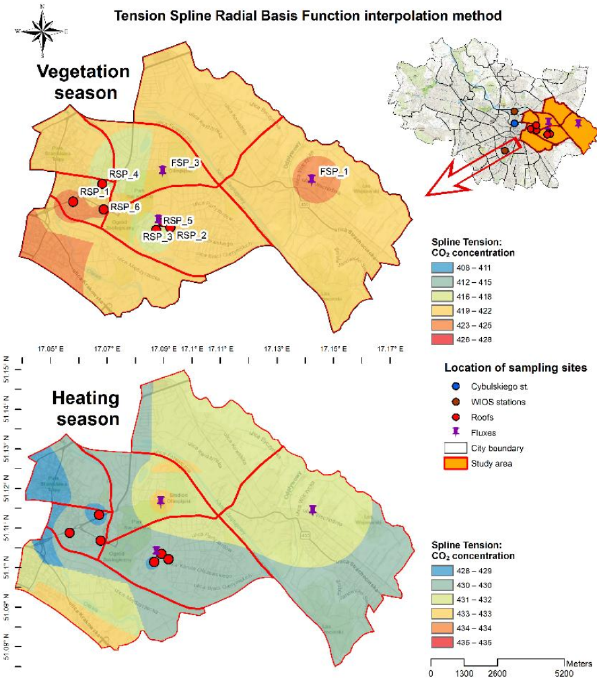
Figure 10. GIS coupling mapping of spatial CO 2 distribution in the vegetation and heating seasons, a surface produced using the tension spline radial basis function interpolation method.